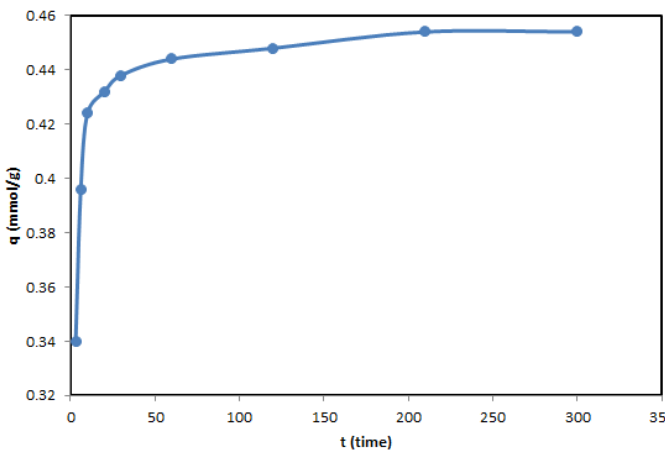
Fig. 8. Diagram of equilibrium uranium ion adsorption as a function of time Fig. 8 .